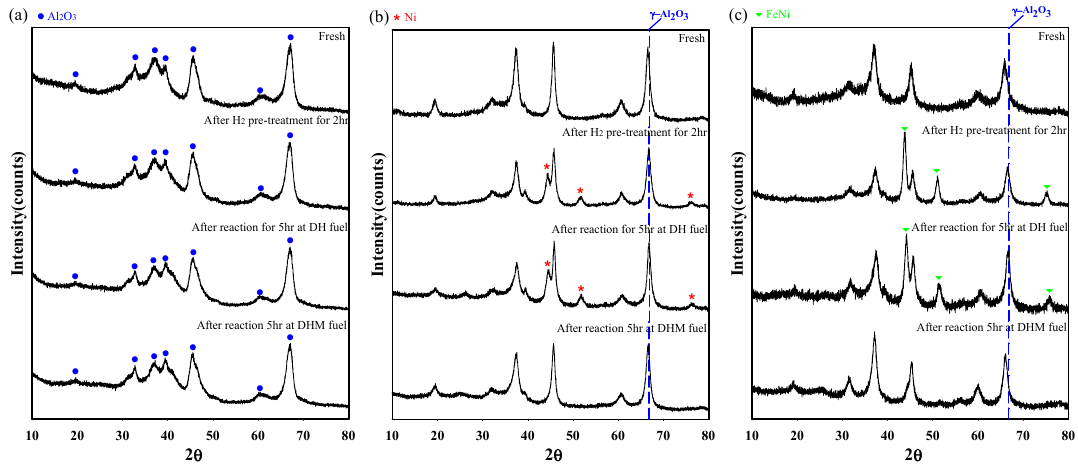
Figure 4. Results of XRD analysis performed on ( a ) R5A-I, ( b ) N10A, and ( c ) F10N10.